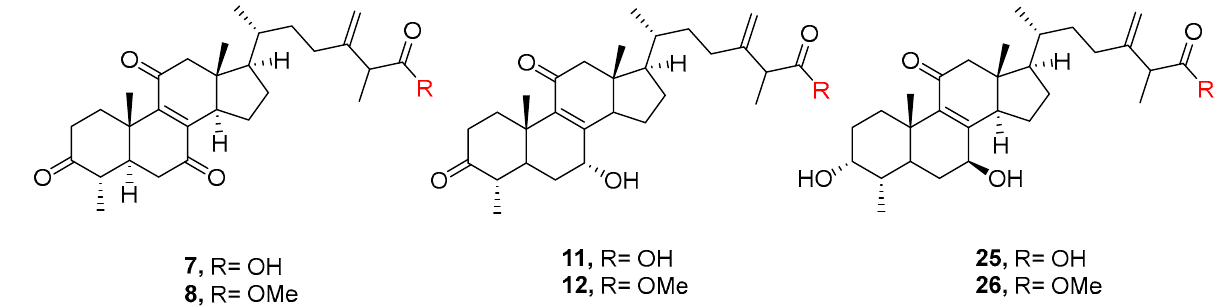
Figure 7. Baseline expression of STAT3 total and STAT3 phosphorylation in HeLaS3 and KBvin. * denotes p < 0.05 as compared to the vehicle control.